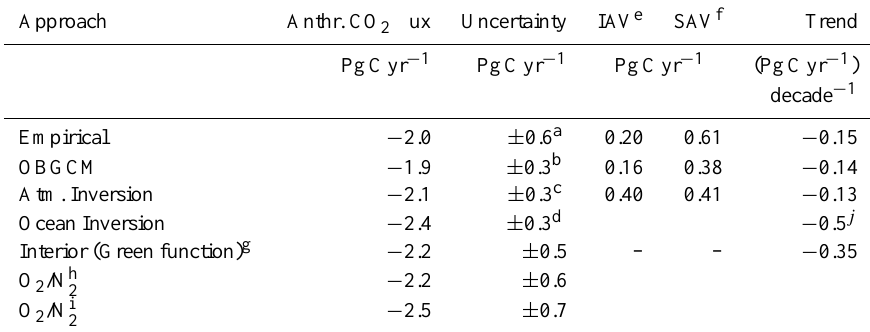
Table 3. Median sea–air anthropogenic CO 2 fluxes for the different approaches centered on year